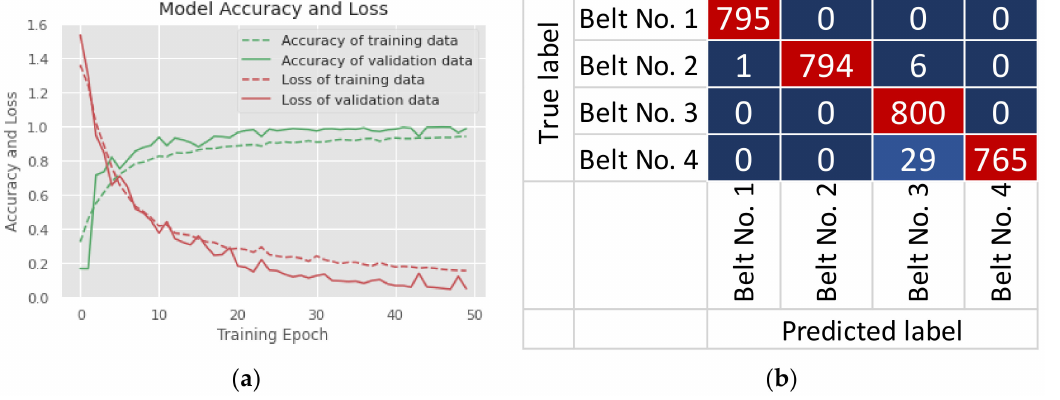
Figure 20. ( a ) Model accuracy and loss; and ( b ) Confusion matrix of triple-axis force data. (Please see Table 2 for detailed information on the classification